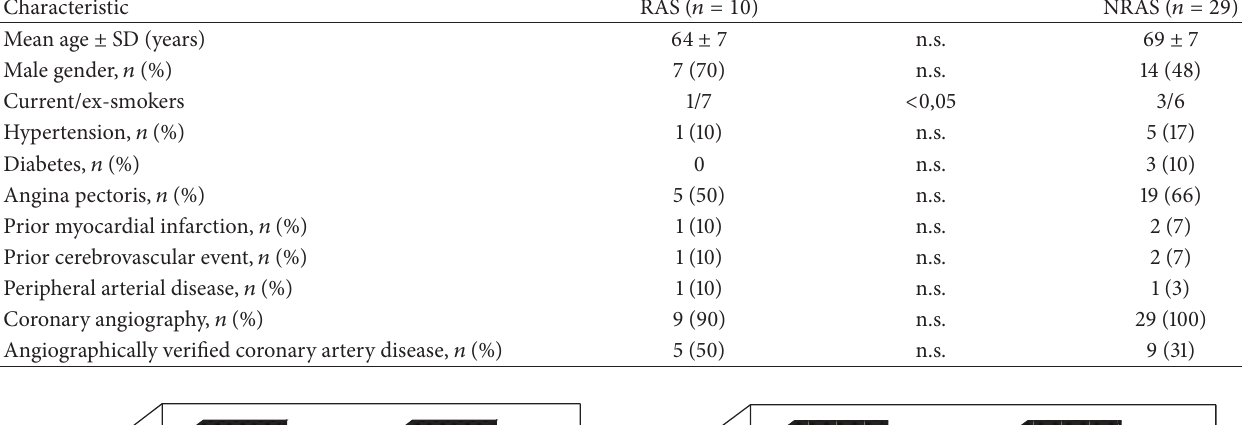
Table 1: Clinical characteristics in RAS and NRAS groups.